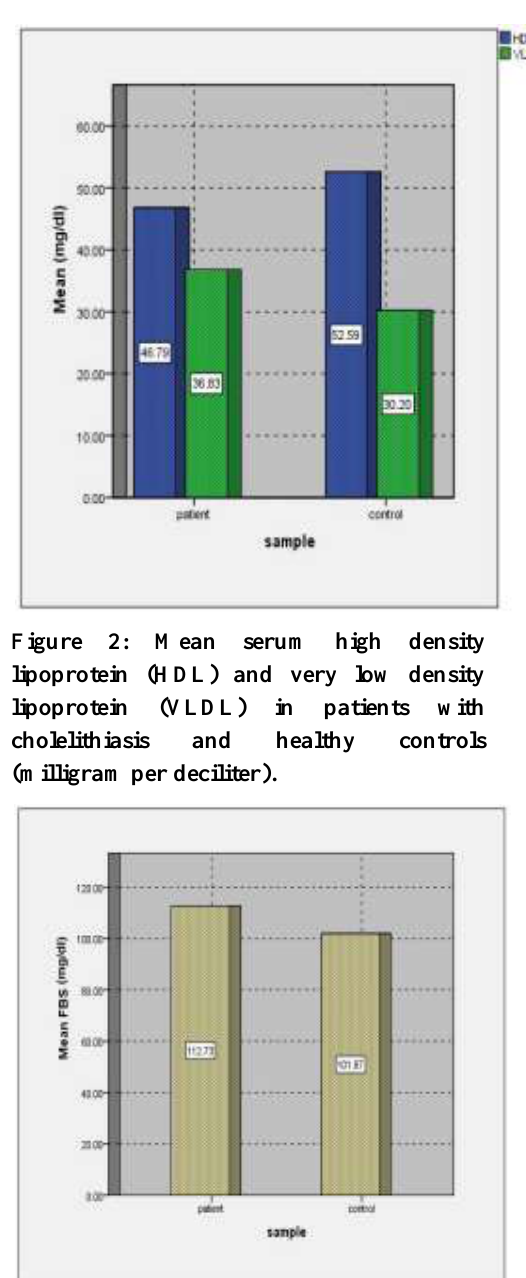
Figure 3: Mean of serum fasting blood sugar (FBS) in patients with cholelithiasis and healthy controls (milligram per